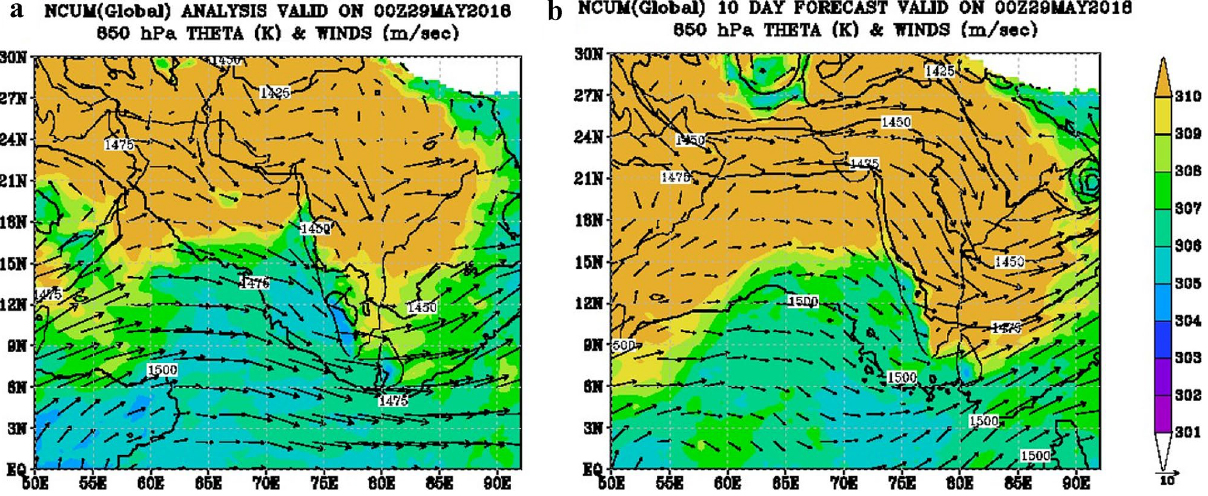
Fig. 7 The spatial distribution of NCUM potential temperature (K, shaded) at 850 hPa overlayed with geo-potential height (m) and the wind vectors valid on 29 May 2018 for a analysis, and b NCUM 10-day